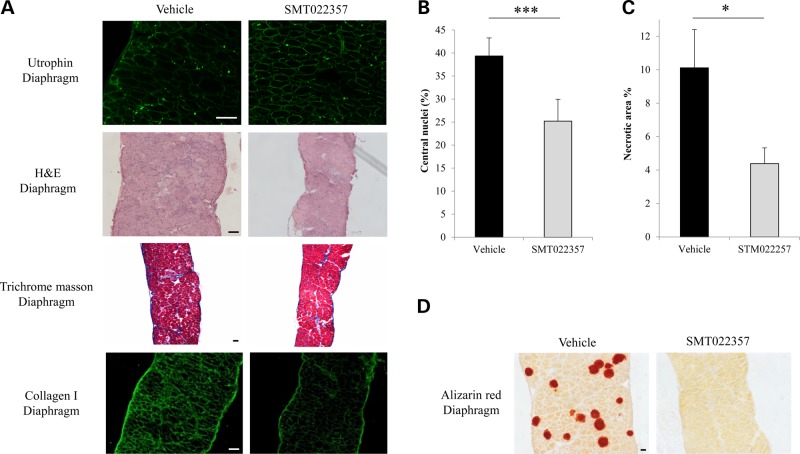
SMT022357 improves the pathology in the diaphragm. (A) Immunofluoresence staining for utrophin in the diaphragm of 7 weeks old mdx mice treated for 5 weeks with 30 mg/kg/day SMT022357 or vehicle (n = 10 per group). Sections were stained with anti-utrophin polyclonal antibody URD40 and anti-rabbit secondary antibody. H&E-stained transverse muscle sections of diaphragm muscle (7 weeks of age) showed improved morphology in treated vs. vehicle mdx mice (n = 10 per group). Masson's trichrome staining of diaphragm in untreated vs. treated mdx mice (n = 8) indicated that SMT022357 treatment reduced the amount of collagen infiltration (stained in blue); immunofluorescence using anti-collagen type I antibody confirmed a decrease of collagen in the muscular endomysium of SMT022357 treated diaphragm. Scale bar 100 µm. (B) Diaphragms of mice dosed with SMT022357 showed a significant 35.9% decrease in centrally nucleated fibres compared to the vehicle group. Values are mean ± SEM of n = 8 per groups; ***P < 0.001. (C) The necrotic diaphragm area of mice treated with SMT022357 significantly decreased by 56.6% compared to the vehicle group. Values are mean ± SEM of n = 8 per group; *P < 0.05. (D) The vehicle mdx diaphragm exhibits positive staining with Alizarin Red indicating the presence of calcium deposits. SMT022357 treatment completely prevented the calcification. (n = 10 per group); Scale bar: 100 µm.